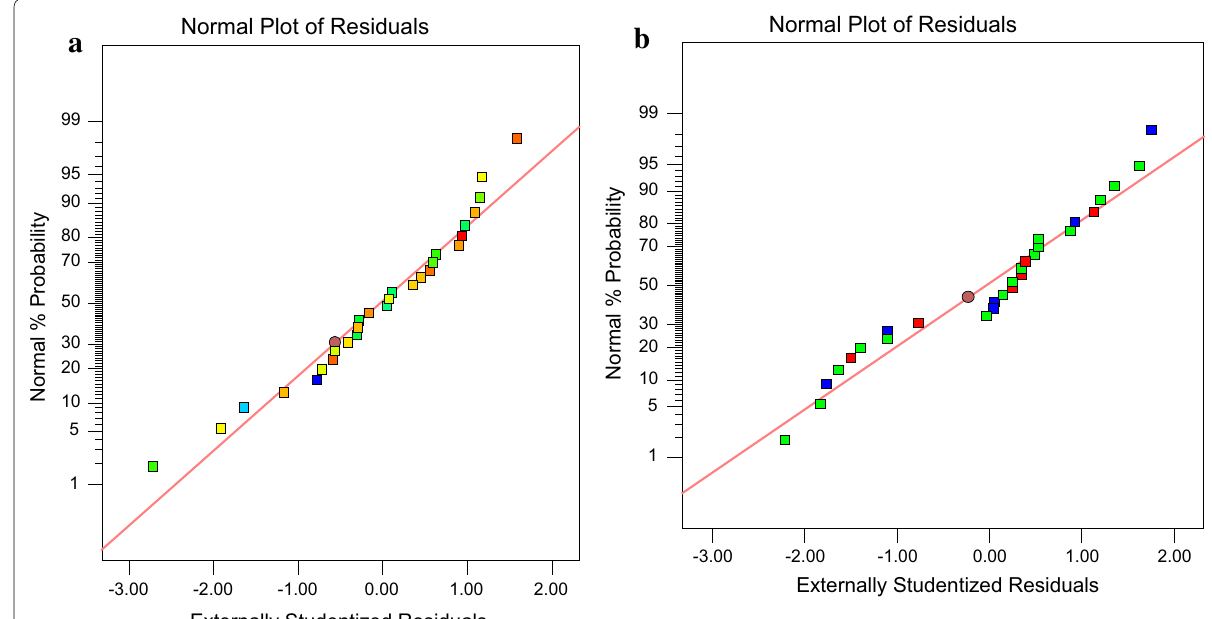
Fig. 1 Normal plot of studentized residuals verses normal % probability of A. niveus for bearing the experiment for a Cr(VI) and b residual